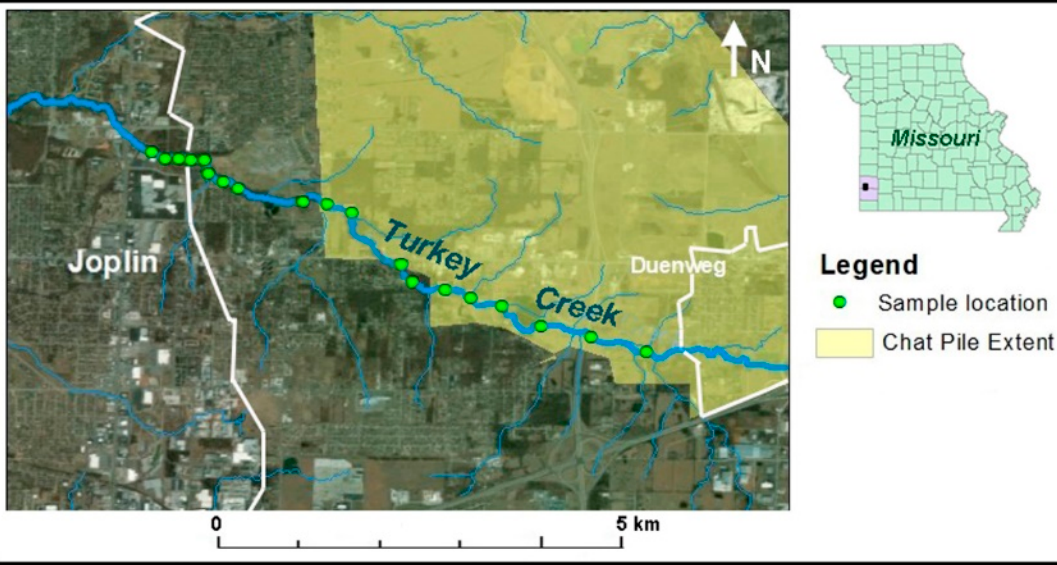
Figure 3. Sampling locations within Turkey Creek, Missouri. Note: This site is 5 km upstream from the area shown in Figure 2.